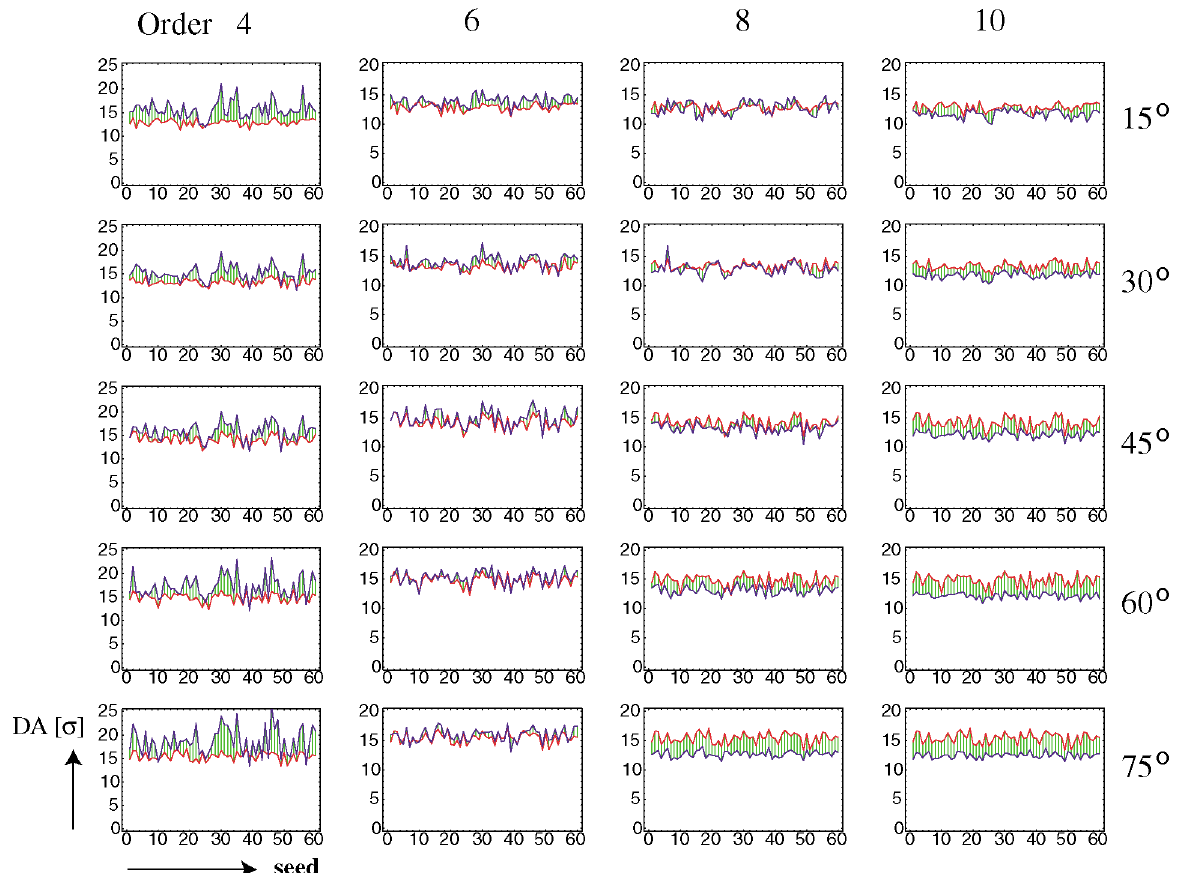
FIG. 5. (Color) Dynamic apertures (DA) computed from the results of direct and Cremona map tracking (orders 4, 6, 8, and 10) for the realistic LHC lattice, version 6. In each plot we show the DA for each of 60 different seeds. The red curves show the results obtained from direct tracking, and the blue curves show those obtained from Cremona map tracking. The comparisons are shown for five different angles. (Note that the vertical scales for order 4 differ slightly from those of the other